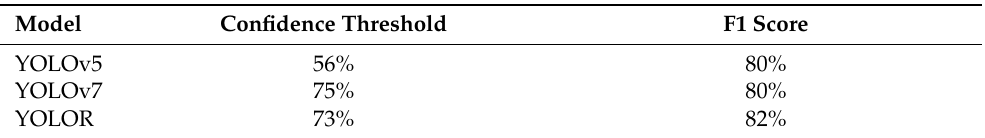
Table 12. Confidence threshold values that optimised the F1 score obtained with the TensorFlow Flower Detection